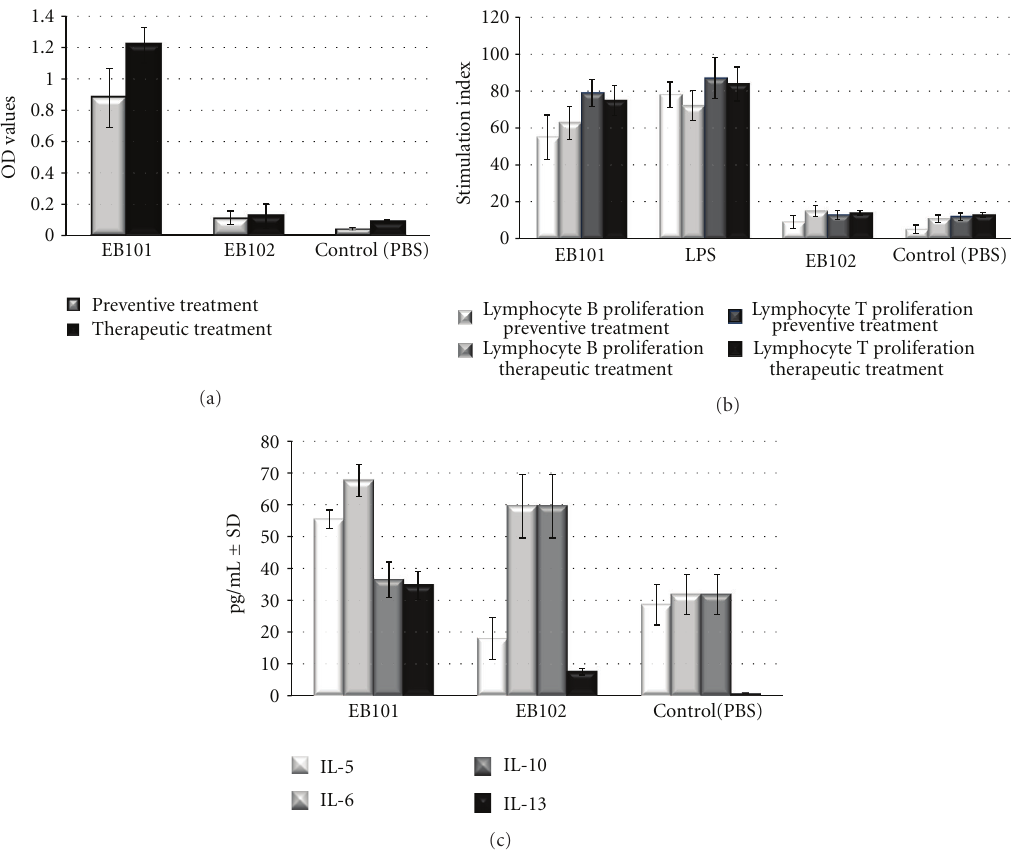
Figure 6: Quantification of IgG antibodies against beta-amyloid and Th1/Th2 cytokine detection after immunization. (a) Presence of anti- β -amyloid in the sera of EB101-vaccinated and control transgenic mice groups after preventive and therapeutic treatment. EB101 led to a quite high increase of IgG antibody production as shown. ELISA was used for sera antibody detection in mice in each group. Each bar represents the background OD mean value ± SEM in each group. (b) Proliferative response of spleen cells from EB101-treated mice and controls after preventive and therapeutic treatment. Results showed that both EB101 and LPS induced B and T lymphocyte proliferative responses. Note that EB101 treatment resulted in an enhanced proliferation response when compared with EB102 and PBS control mouse groups ( P ≤ 0 . 01). The results obtained from triplicate assays were expressed as stimulation indices (ratio between mean OD ± SEM from stimulated and unstimulated cultures). (c) Detection of Th1 and Th2 cytokines in transgenic mice after therapeutic treatment. Analysis of variance (ANOVA) for IL-5, -6, -10, and -13 indicated significant di ff erences between vaccinated and control groups. Results are shown as mean pg/mL ±